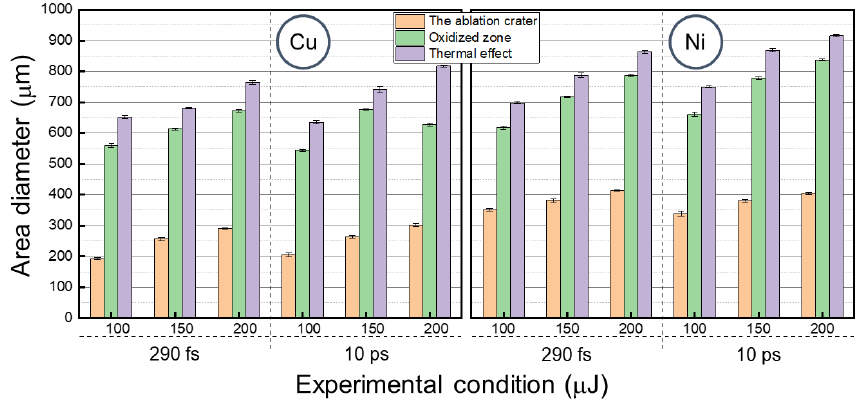
Figure 6. Regional variations in surface morphology of laser ablation of copper and nickel with different energies and pulse widths for 1000 pulse numbers.